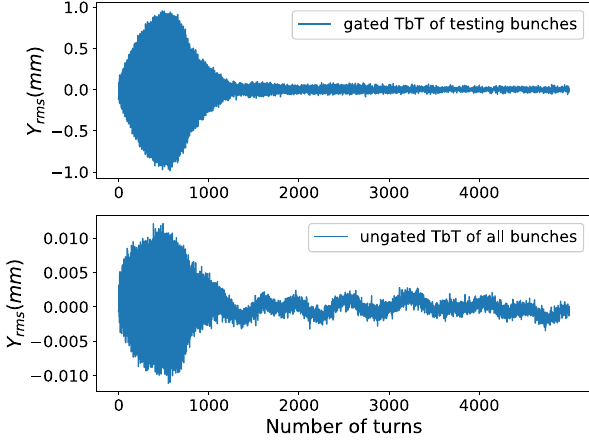
FIG. 7. Comparison of the gated BPM TbT data of the DBT (top) and the ungated TbT data averaged over all filled buckets (bottom). Although the DBT amplitude reaches 1 mm for a few ms, the disturbance on the global beam stability is negligible. The ungated data of the combined bunch trains sees noise from either the power supplies or the rf cavities. Note that the two subplots ’ vertical scales are